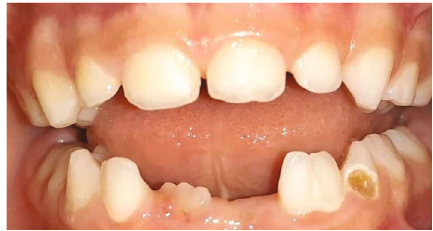
Figure 6: Fusion of the clinical crown of tooth 72 with a supernumerary tooth 72 ’ .